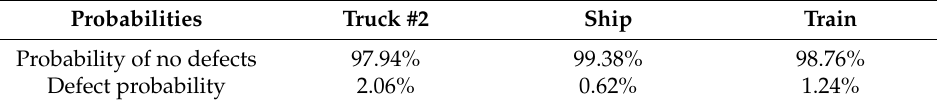
Table 4. Defect probabilities of the transport relations in the simulation model.